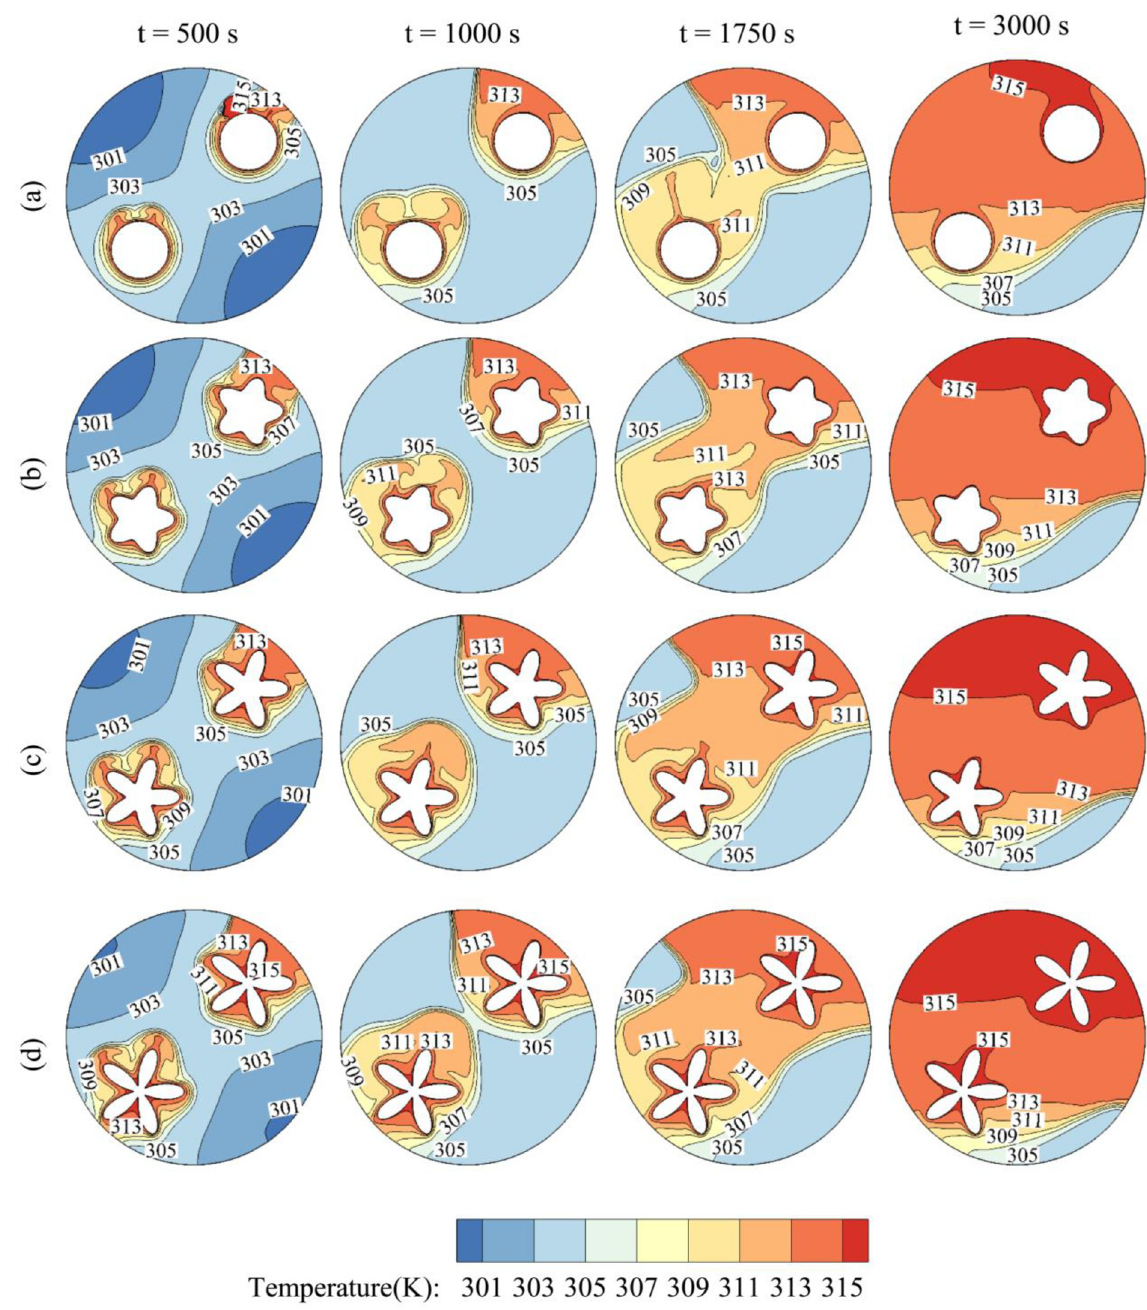
Fig 14. The contours of Temperature and the effects of the sinusoidal amplitude of the quasi-petal heat pipe on contours of Temperature. (a): A = 0; (b): A = 0.05 r s ; (c): A = 0.10 r s ; (d): A = 0.15 r s when r d = 0.6 r s , Λ = 5, and η = π /4. same time, it increases E . The longest total melting time and the lowest E total in the case of an inner tube with a circular cross-section (A = 0). These results indicate that using a quasi-petal heat pipe, even with a low petal sinusoidal amplitude A, provides better PCM melting contribution compared to a circular tube and that increasing A improves such contribution.